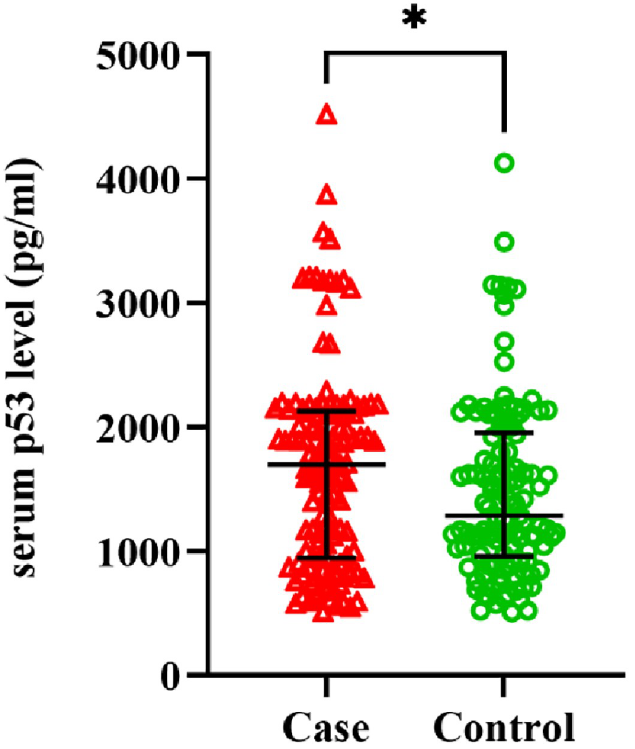
Fig 1. Differences in serum p53 expression level between control and cases with cervical cancer [cases: {median: 1697 pg/ml, IQR: 946–2128}; controls: {median: 1285 pg/ml, interquartile range (IQR): 957.8–1953}; Wald chi- square, ( χ 2 ) = 3.81, df = 1, adjusted P = 0.0442]. Error bars represent median ± interquartile range � P < 0.05.